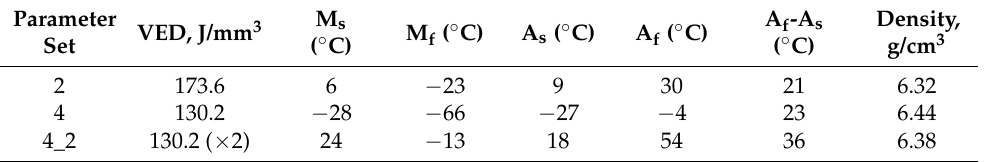
Table 8. Martensitic phase transformation temperatures of the NiTi 50,7